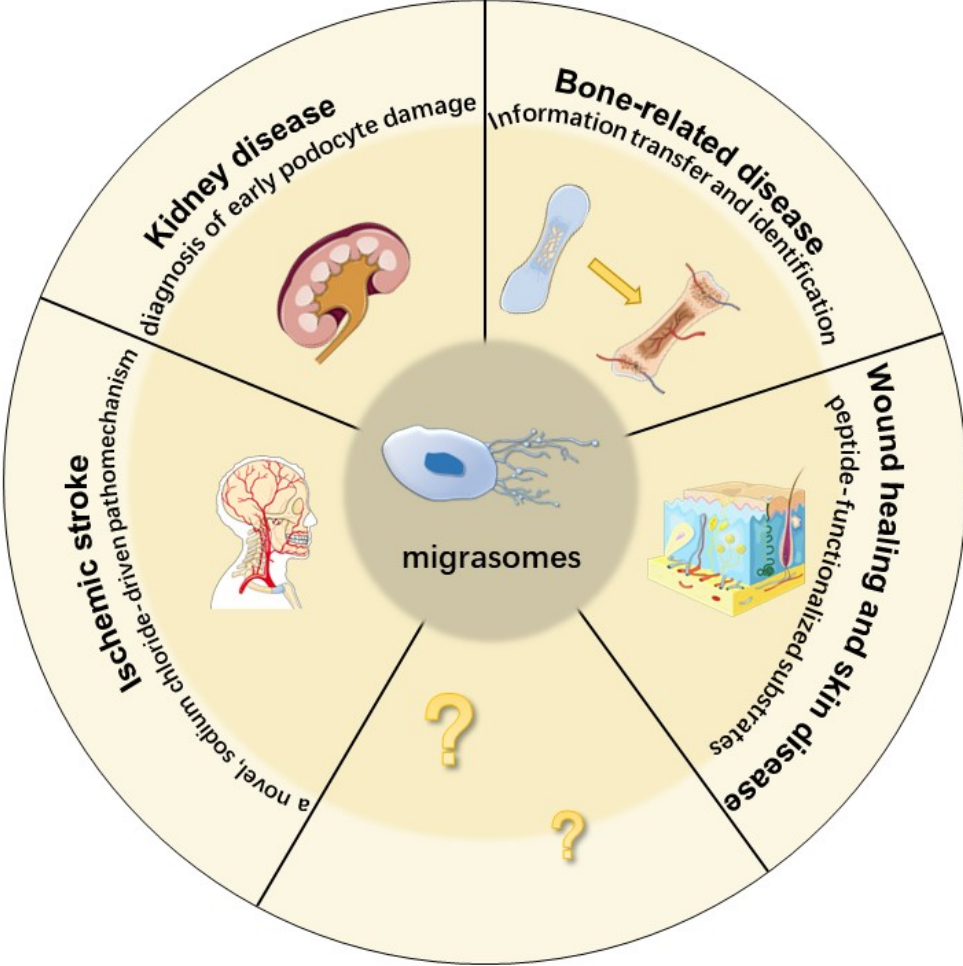
Figure 2. Migrasomes and related diseases.